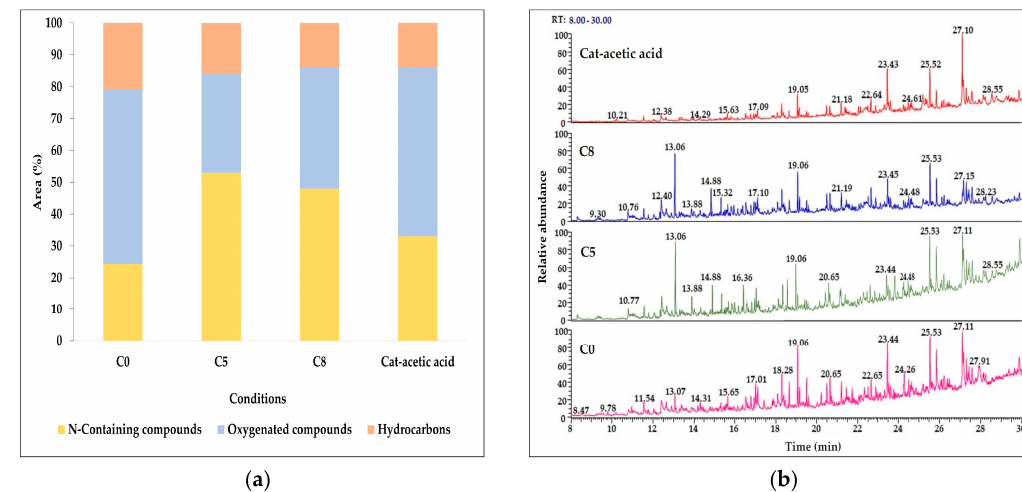
Figure 8. ( a ) E ff ect of aqueous phase recycling on the composition of bio-crudes, and ( b ) chromatograms Figure 8. ( a ) Effect of aqueous phase recycling on the composition of bio-crudes, and ( b ) of chromatograms of bio-crudes.